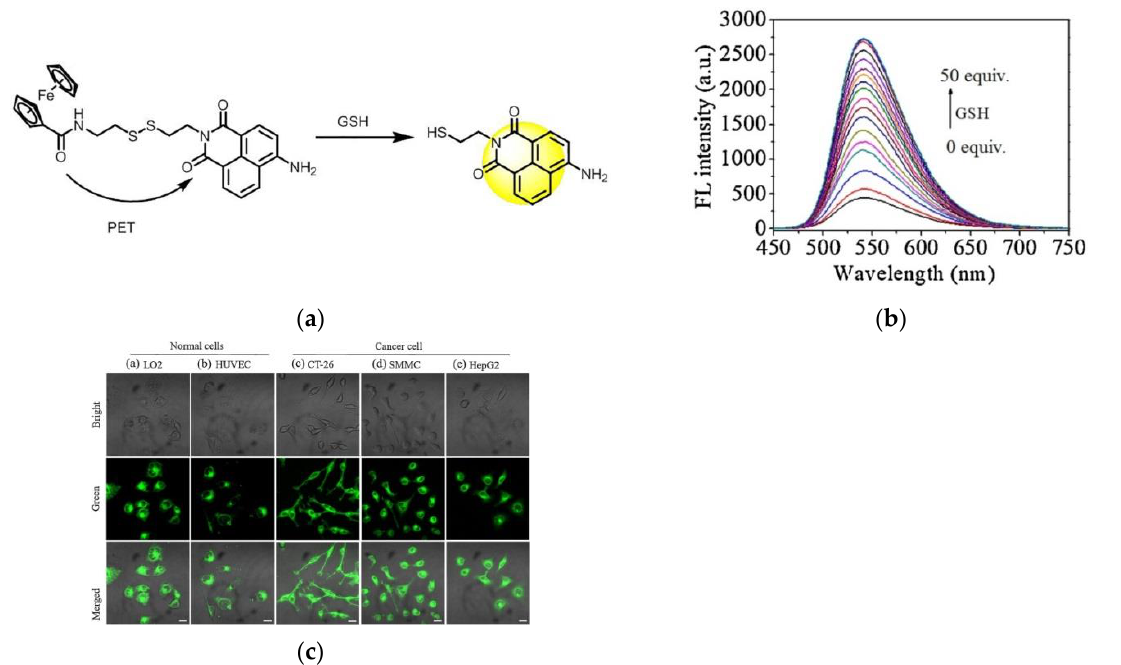
Figure 21. ( a ) Mechanism of Naph-SS-Fc activation by GSH; ( b ) The GSH concentration-dependent fluorescence spectra; ( c ) The CLSM imaging of cells after incubating with Naph-SS-Fc. Reproduced with permission from [92]. Copyright 2020 Elsevier B.V. on behalf of Chinese Chemical Society and Institute of Materia Medica, Chinese Academy of Medical Sciences.